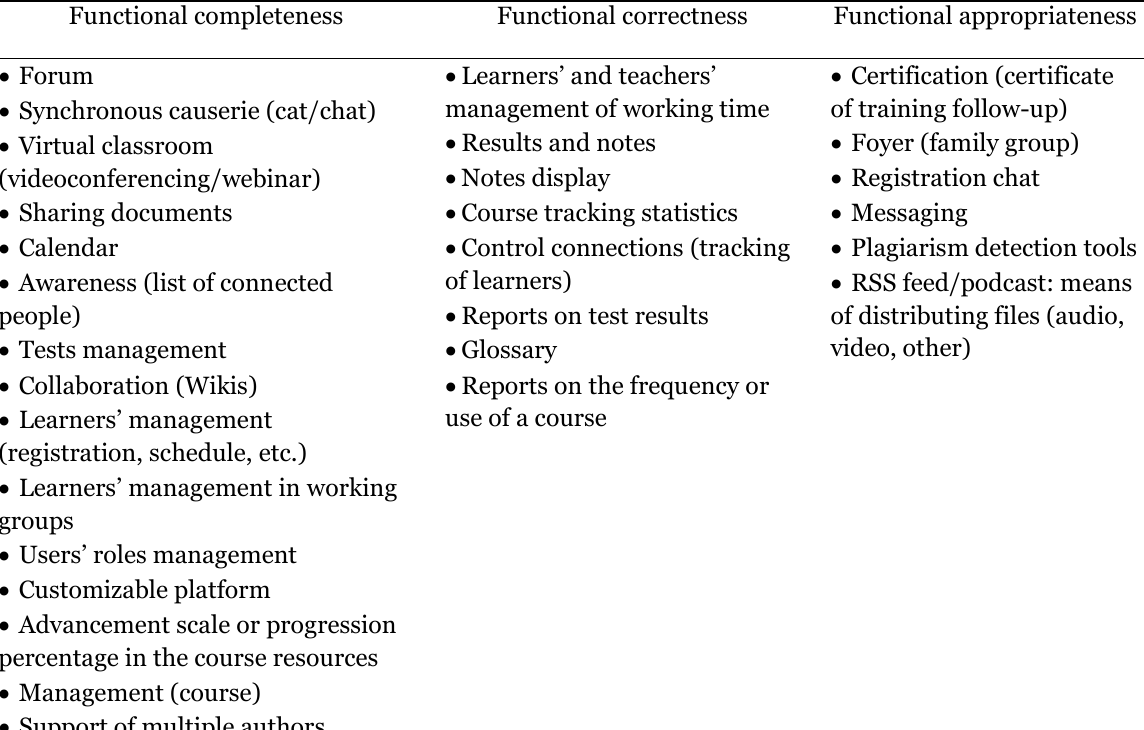
Characteristics Selected for Evaluating the Functional Suitability of an E-Learning Platform Functional